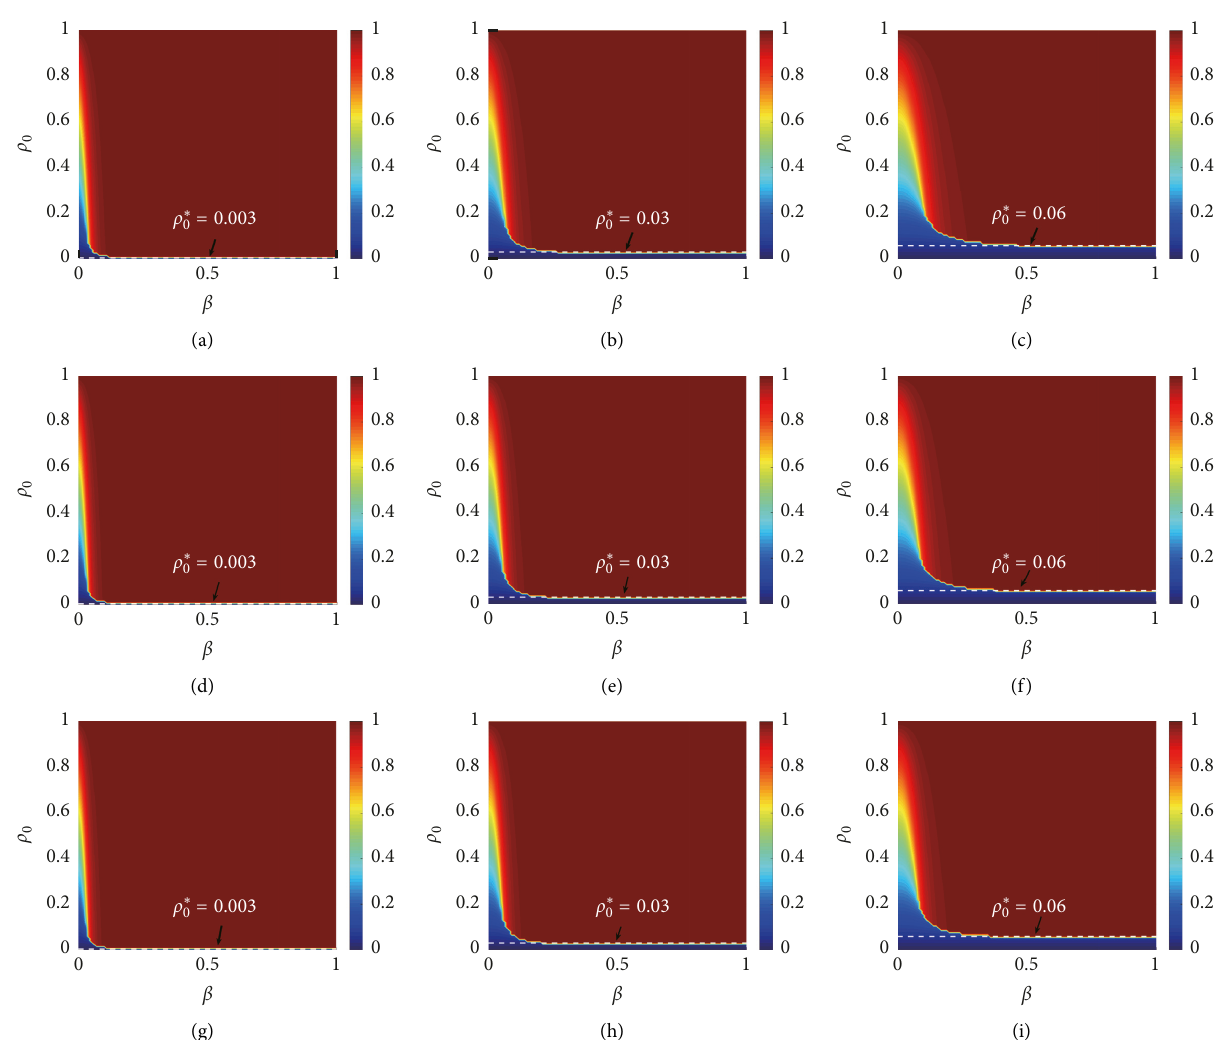
Figure 5: Illustrations of the growth pattern of R ( ∞ ) on the ( β , ρ to the theoretical method, the final adoption size R ( ∞ ) versus the parameter pair ( β , ρ (a), (b), and (c) from row 1 with T A � 1 ,T B � 1; (d), (e), and (f) from row 2 with T A � 1 , T B � 2; and (g), (h), and (i) from row 3 with T � 1 , T � 3. The subgraphs have weight distribution exponents of α A A B � 3 . 5 in column 3. All subgraphs show that a critical seed size ρ ∗ α B ω which a global adoption becomes possible. Additionally, the changes in the subgraphs from the first column to the third confirm that increase the weight distribution exponents (decreasing weight distribution heterogeneity) can promote information spreading. The basic parameters are N � 10 4 , 〈 k 〉 � 10, 〈 ω 〉 � 8, ρ